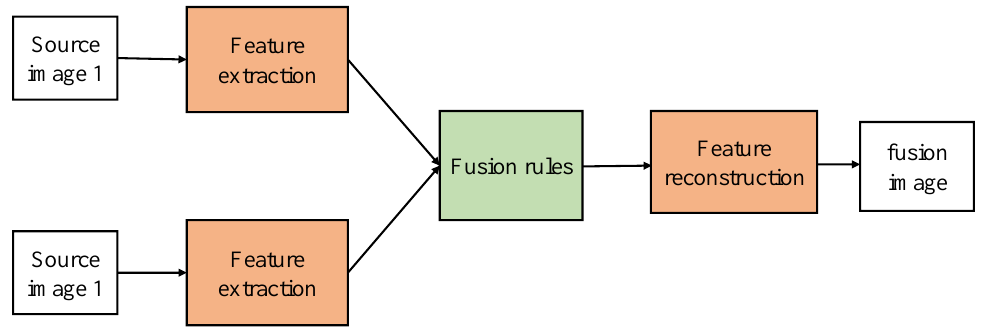
Figure 2. Traditional image fusion framework.